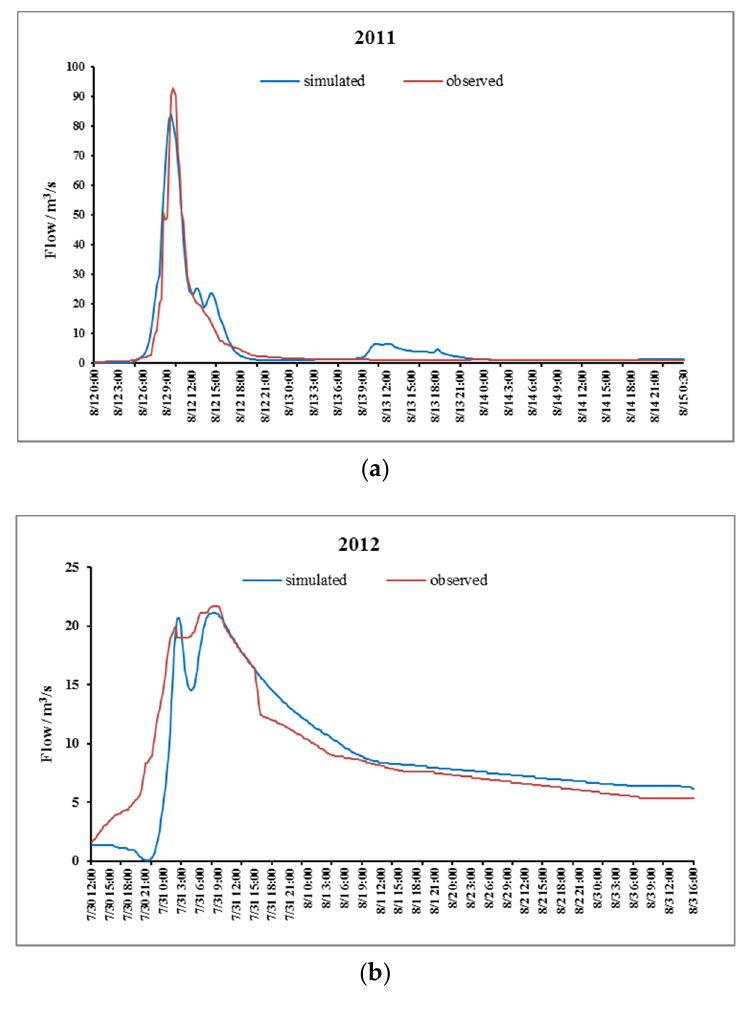
Figure 11. Observed and simulated hydrographs of the 2010s. Table 8. Simulated results and evaluation criteria.